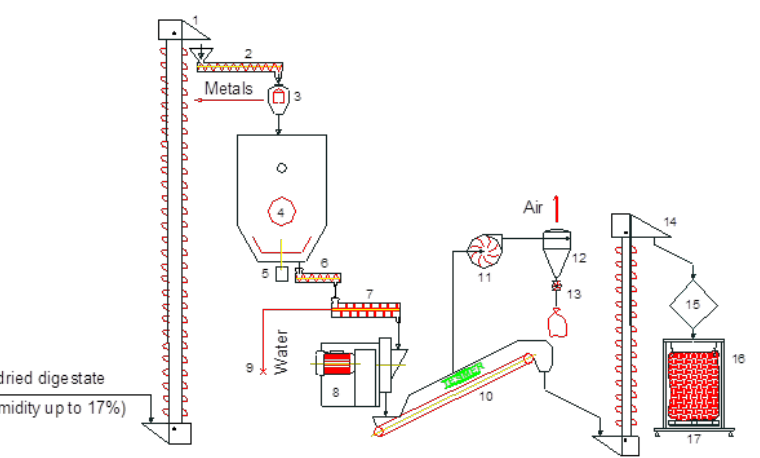
Figure 6. A technological diagram of an exemplary assembly line for granulation of dried post- fermentation subtract: 1—bucket elevator (2.2 kW), 2—screw conveyor (2.2 kW), 3—magnetic detec- tor, 4—tank with filling, 5—tank lifting agitator (2.2 kW), 6—screw feeder (0.75 kW), 7—conditioner (2.2 kW), 8—granulation press (11 kW), 9—water dispensing installation, 10—conditioner (0.75 kW), 11—centrifugal fan (2.2 kW), 12—cyclone, 13—subcyclone sluice (0.55 kW), 14—bucket elevator